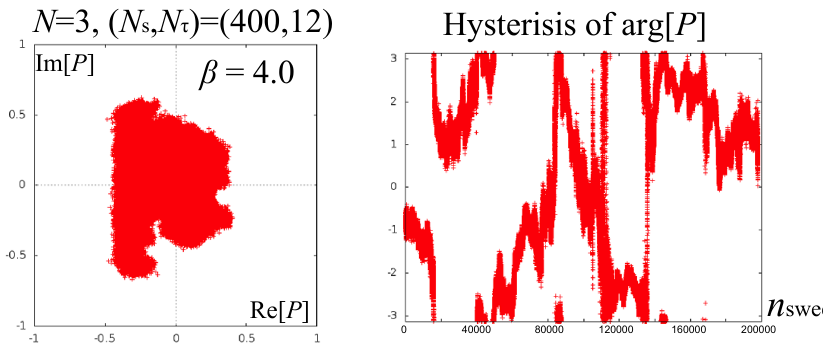
Figure 9 . (Left): distribution plot of the Polyakov loop for N = 3, (cid:12) = 4 : 0 with ( N s ; N (cid:28) ) = (400 ; 12) for Z N -TBC. (Right): the corresponding hysterysis of arg[ P ] for N = 3, (cid:12) = 4 : 0 with ( N s ; N (cid:28) ) = (400 ; 12).